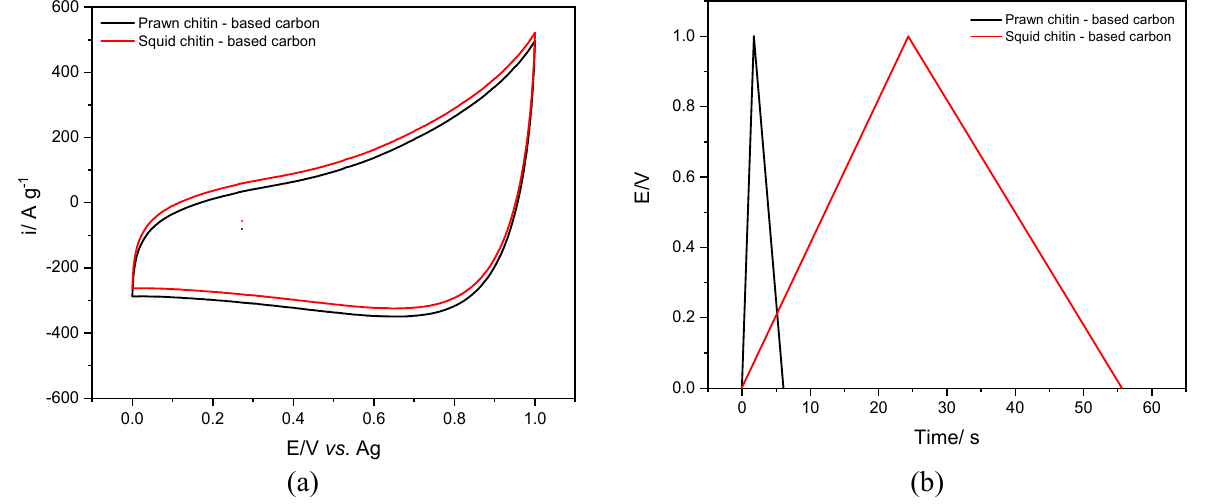
Figure 9. Electrochemical performance of the squid and prawn chitins-based biocarbon composite electrodes/DES (ethaline) interface in a three-electrode set-up, ( a ) cyclic voltammetry at 50 mV s − 1 , and ( b ) galvanostatic charge-discharge curves (GCD) recorded with current density 1 A g − 1 , at 30 ◦ °C.